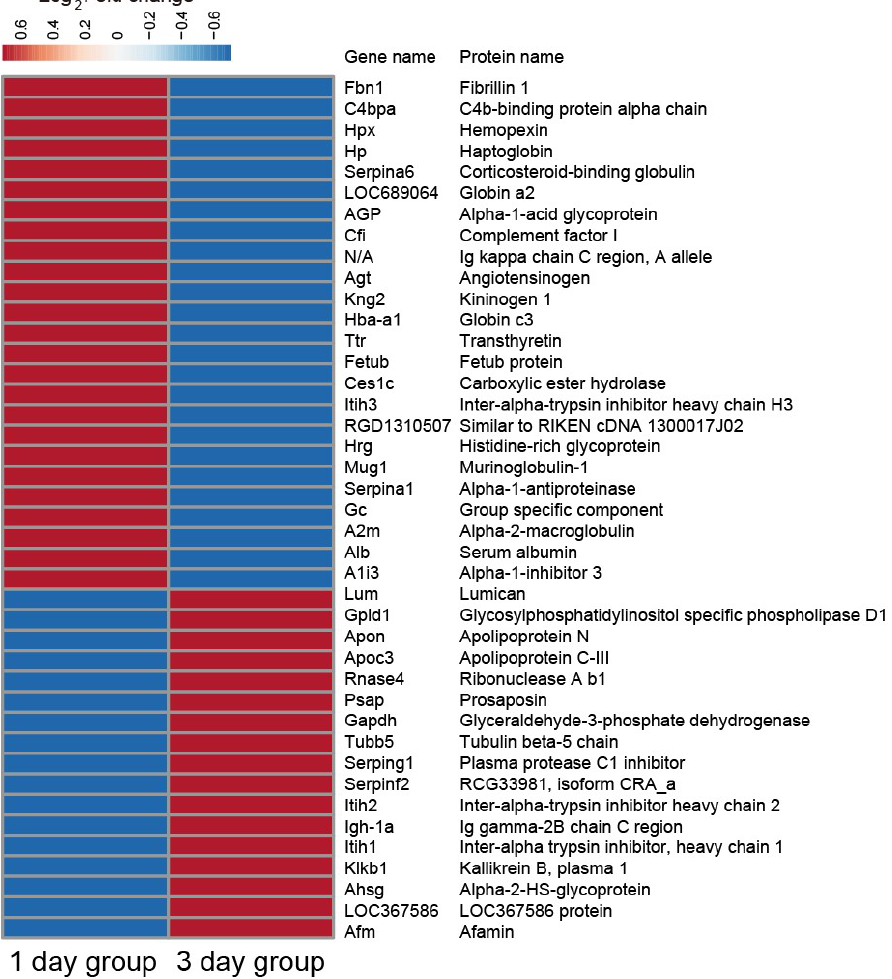
Figure 7. The heat map of the 43 differentially expressed proteins. Red, up-regulation; blue, down-regulation.